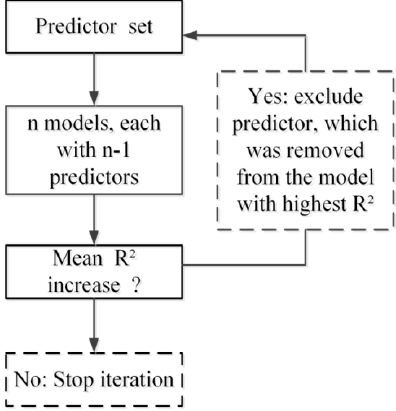
Figure 2. Flow chart of the stepwise predictor exclusion.